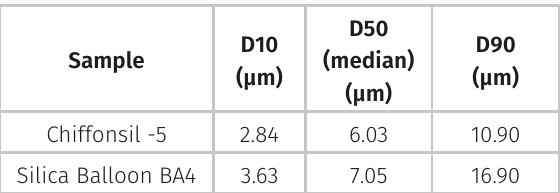
Table III. Granulometric analysis data for silica samples – Mie